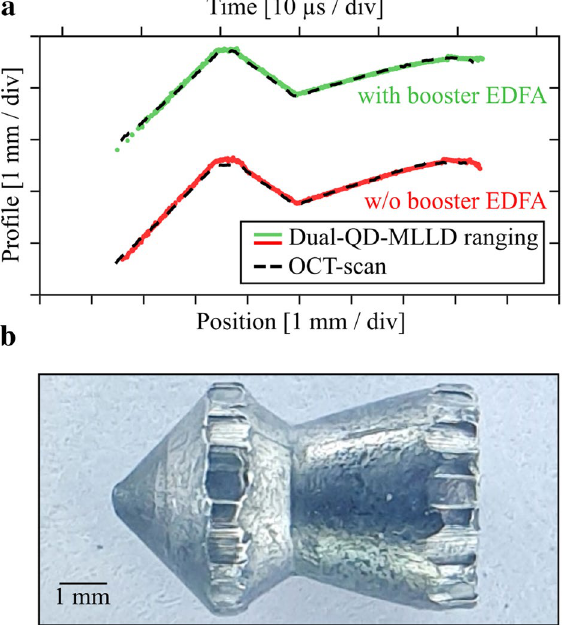
Figure 5. Surface profile measurements of air-gun projectile passing the measurement beam at a speed of approximately 150 m/s. ( a ) Surface profiles measured on the flying projectile, using the one-port ranging system, (Fig. S6 in the Supplementary Information), with EDFA (green) and without EDFA (red). The free-space signal beam power amounts to 9 dBm and 22 dBm for the measurement with and without EDFA, respectively. For better visibility, the red and the green curve are separated by a vertical offset. The black dashed curves denote the profiles of both investigated projectiles, obtained from an optical coherence tomography (OCT) measurement on the static projectile after recovery from the back-stop. ( b ) Photograph of the projectile measured in ( a ), red